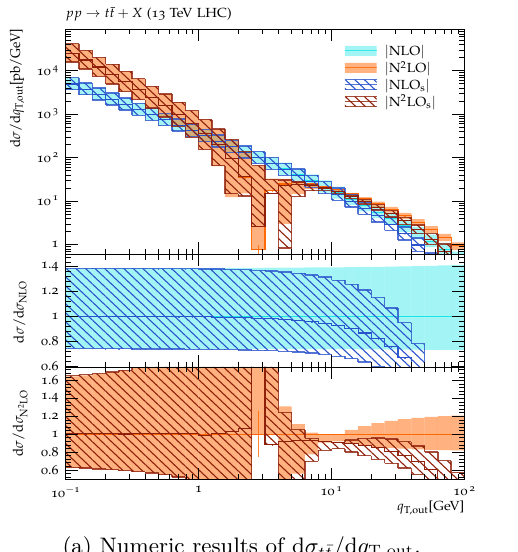
Figure 6 . The fixed-order results of the q T , out and the weighted q T , out spectra of the pro- cess pp t ¯ t + X at √ s = 13 TeV. NLO/N 2 LO represents the differential cross section calcu- → lated in the full QCD, while NLO s /N 2 LO s encodes the leading singular behaviour derived from SCET II +